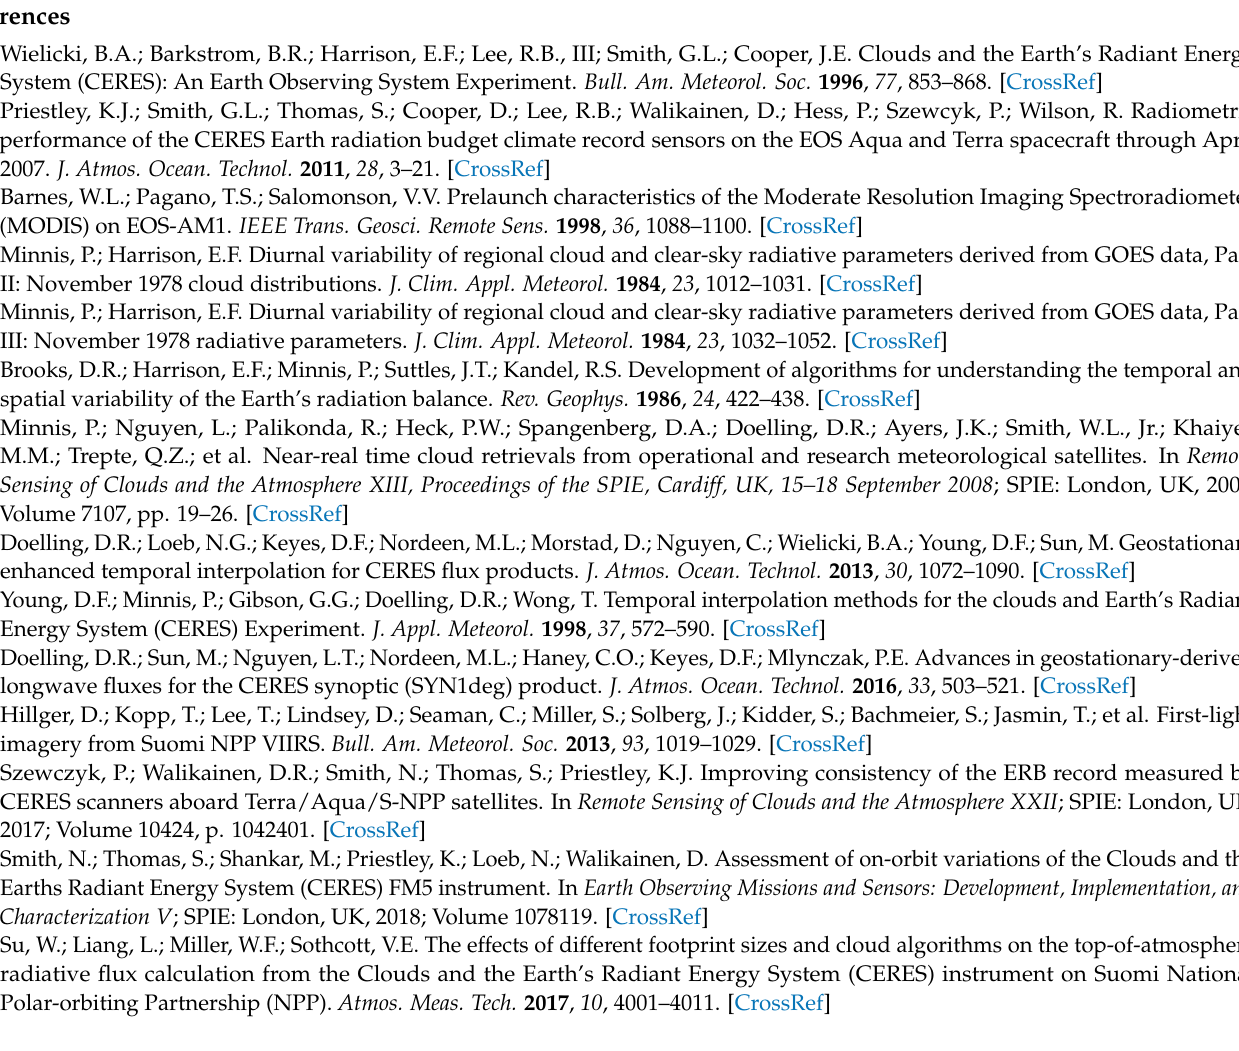
April 2013. Figure S4: Same as Figure S3, except for the ice clouds. Table S1: Mean multilayer cloud fraction from Aqua Ed4 and SNPP Ed1a, 2013. Table S2: Mean multilayer cloud-top height (km) for the upper and lower layers from Aqua Ed4 and SNPP Ed1a,